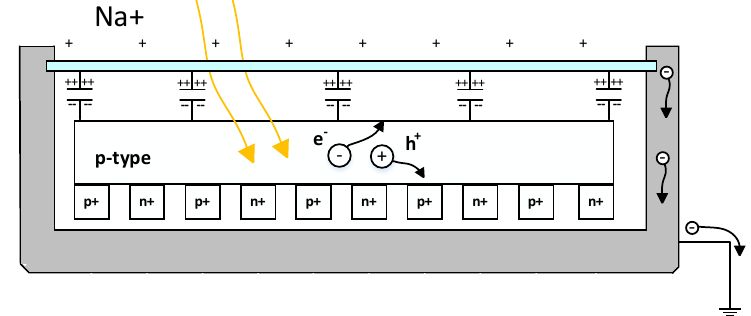
Figure 1. A cross-section of a p-type PV panel that is losing electrons due to PID.